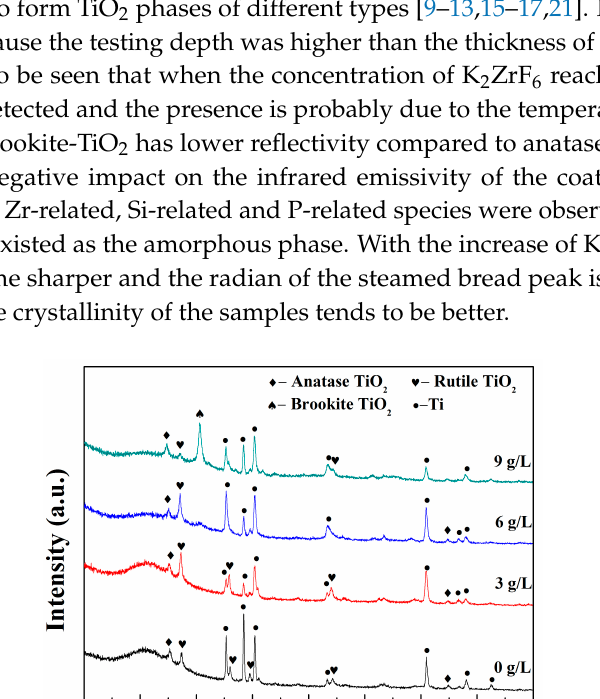
Table 1. Element content of MAO coatings prepared under different K 2 ZrF 6 concentrations.